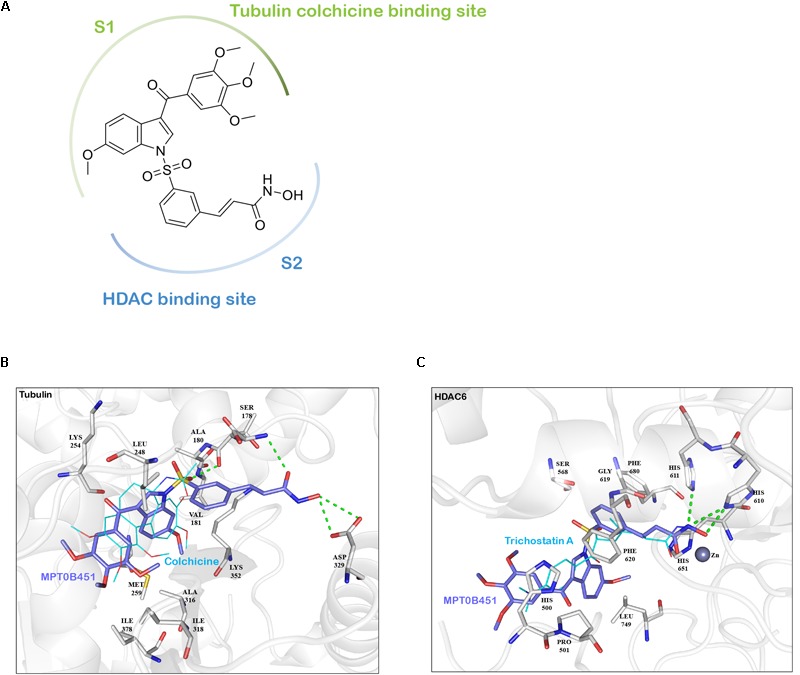
The interaction between MPT0B451 and target proteins analyzes by molecular docking analysis. (A) MPT0B451 can be separated into two sub-structures: 6-methoxy-3-(3′,4′,5′-trimethoxybenzoyl)-1H-indole (S1, green) and (E)-N-hydroxy-3-(3-sulfonylphenyl)acrylamide (S2, blue). (B) MPT0B451 (purple) is docked into the colchicine binding site of tubulin (gray, PDB ID: 4O2B). The co-crystallized ligand, colchicine (aqua), was used as a reference and aligned to MPT0B451. Green lines represent hydrogen bonds. Residues are labeled as shown. (C) MPT0B451 (purple) is docked into HDAC6 (gray, PDB ID: 5EDU). The co-crystallized ligand Trichostatin A (aqua) was used as a reference and aligned to MPT0B451. Green lines represent hydrogen bonds. Residues are labeled as shown.